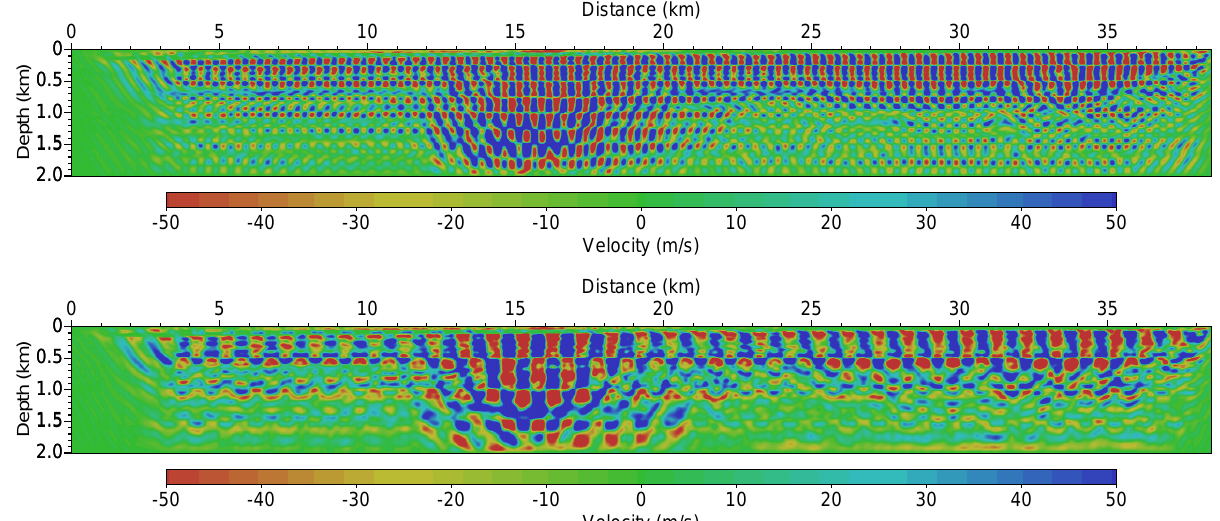
Figure 17. Checker board results for final velocity model with 5% perturbation. Check size of ( a ) 250 m and ( b ) 500 m are used for velocity